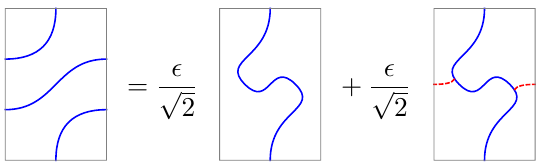
Figure 34 . Applying the H-junction crossing relations to the T 2 transformation of N line in time direction.